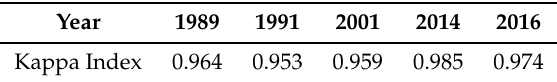
Table 4. Estimation of accuracy for random forest land cover